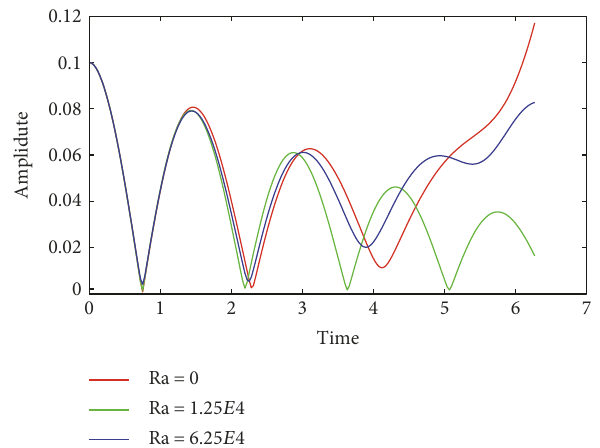
Figure 7: Curves of interface amplitude versus time when Ra=0,